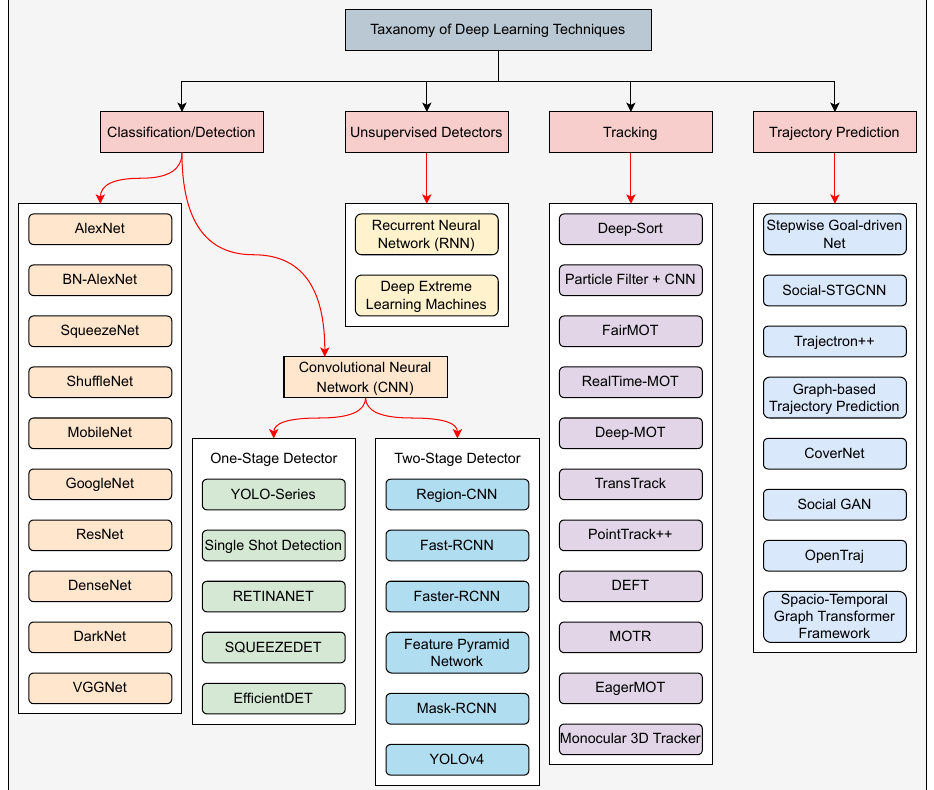
Figure 10. Overview of deep learning algorithms of classification/detection, tracking and trajectory